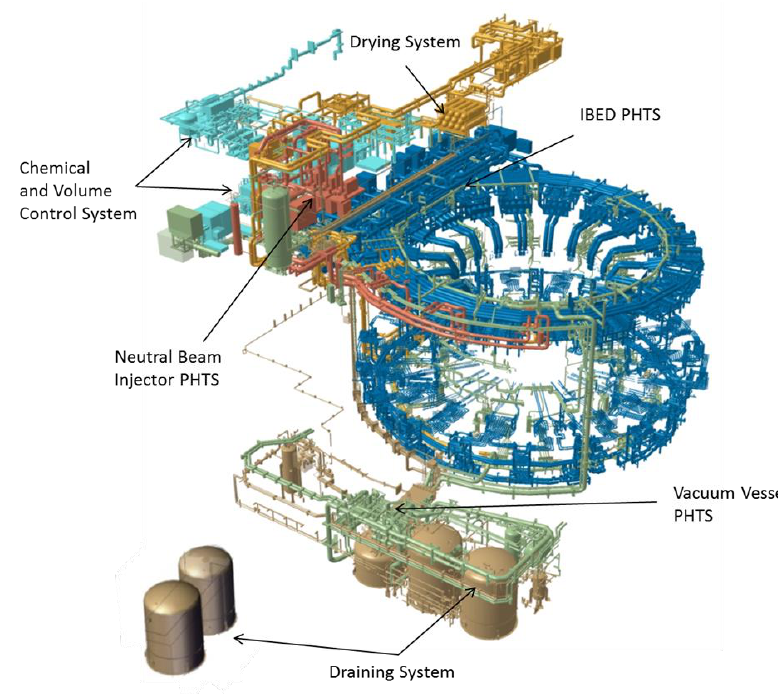
Figure 8. Tokamak Cooling Water System. General View [35].